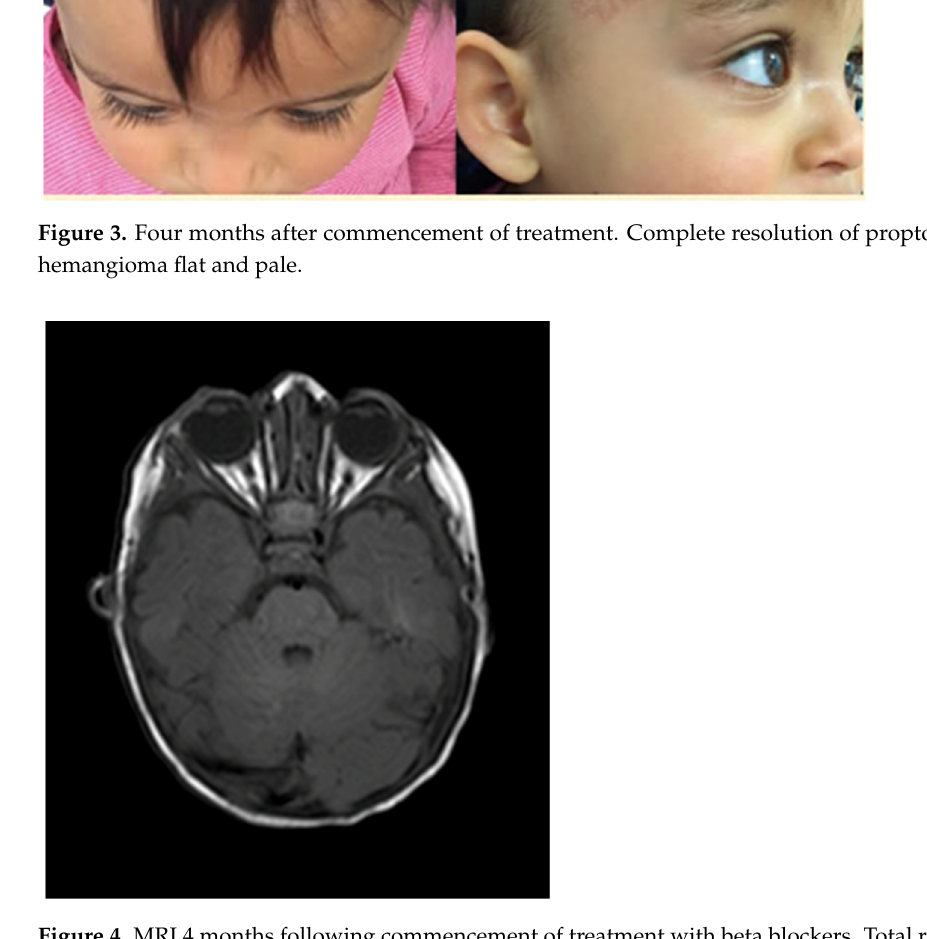
Figure 4. MRI 4 months following commencement of treatment with beta blockers. Total resolution of the orbital hemangioma and of the associated intracranial extension.